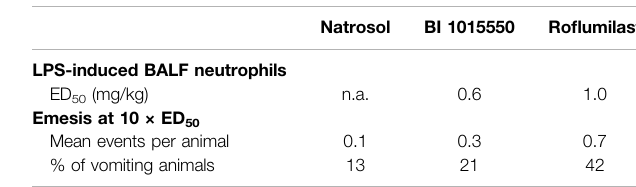
TABLE 2| Comparison of oral BI1015550 and ro fl umilast in Suncus murinus with respecttopharmacodynamicef fi cacy(inhibitionofLPS-inducedneutrophilsin BALF) and emesis induction. Data for ro fl umilast were obtained under identical conditions as described for BI 1015550. ED 50 of ro fl umilast was determined with doses of 0.3, 1, and 3 mg/kg and 8 animals per group; emesis wasestimated with 24 animals for both compounds. BALF, bronchoalveolar lavage fl uid; ED 50 , effective dose forhalf-maximal inhibition; LPS, lipopolysaccharide; n. a., not